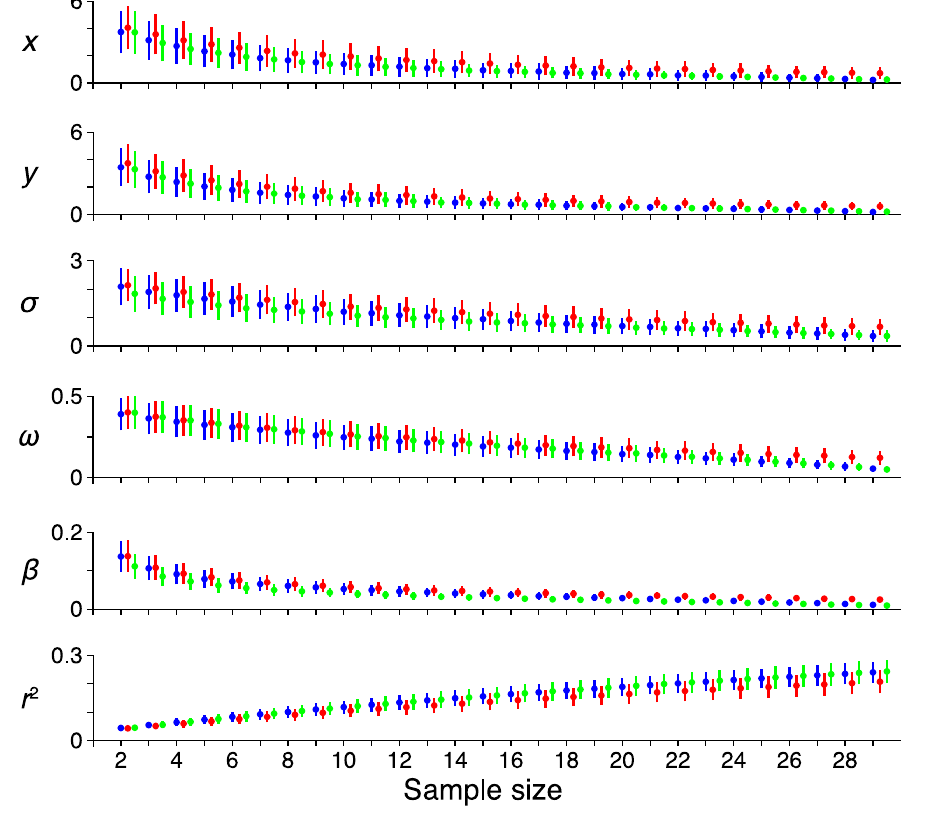
Figure 6. Reliability. The effect of increasing sample size on the error rates among the different pRF model parameters. Each color represents a single subject. The average error among all voxels for a sample size and the reference pRF estimate computed from all runs are shown as a dot, with error-bars showing the 95% confidence intervals. Each row shows a different pRF parameter ( x , horizontal location; y , vertical location; σ , receptive field size; ω , transient-sustained weight; β , response amplitude; r 2 , variance explained).